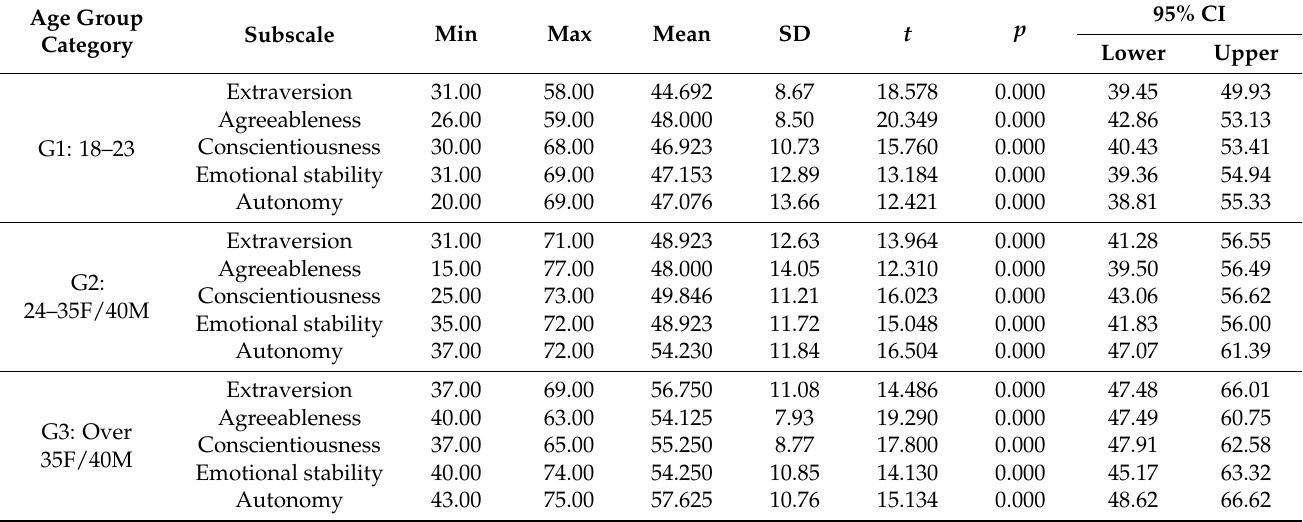
Table 2. Descriptive statistics of the results for the Five-Factor Personality Questionnaire (CP5F)